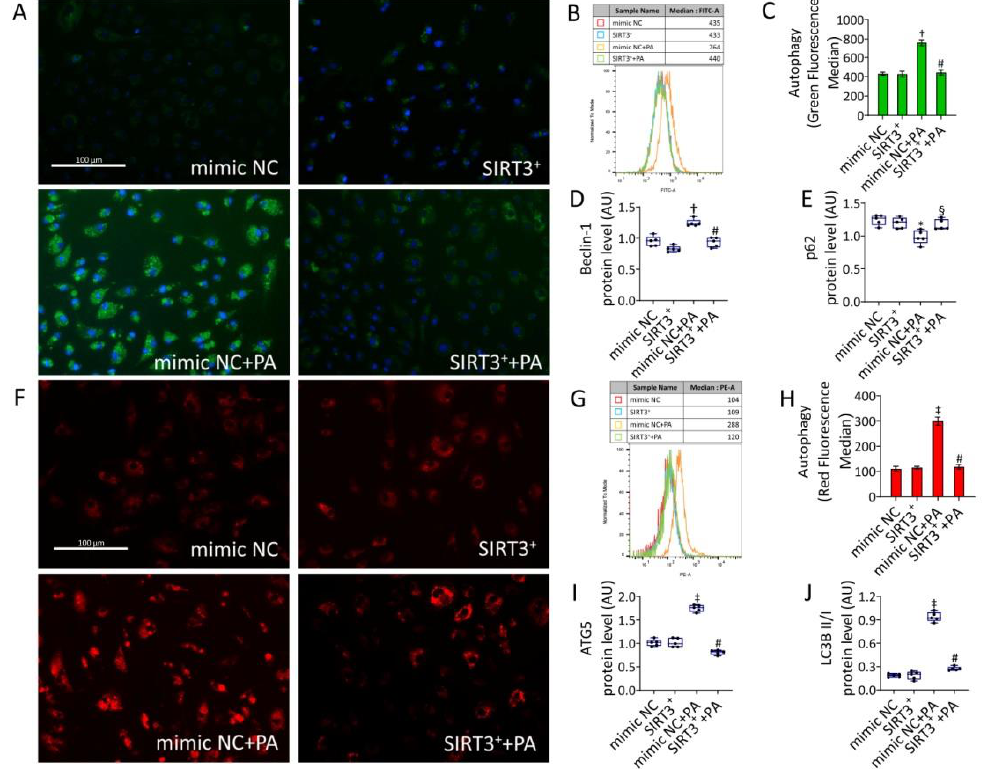
Figure 6. SIRT3 + decreased the PA-induced autophagy. Representative images of fluorescence mi- croscopy and flow cytometry analysis of ( A – C ) green detection reagent and ( F – H ) Lysotracker Red, quantified as MFI (scale bars = 100 µm). Western blotting analysis of ( D ) beclin-1, ( E ) p62, ( I ) ATG5, and ( J ) LC3B II/I in EC transfected with mimic Negative Control (mimic NC), SIRT3 mimic (SIRT3 + ), mimic Negative Control and then exposed to 0.5 mM PA for 48 h (mimic NC+PA) or SIRT3 mimic before 48 h treatment with PA (SIRT3 + +PA). Western blotting results ( n = 5) are expressed as arbi- trary units (AU) and represented as boxplots. † p < 0.01 vs. mimic NC; ‡ p < 0.001 vs. mimic NC; § p < 0.05 vs. mimic NC+PA; # p < 0.01 vs. mimic NC+PA.